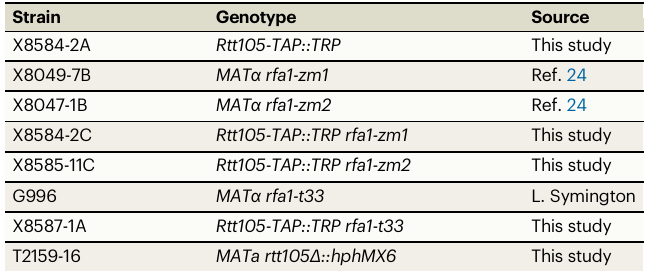
Table 1 | S. cerevisiae strains used in this